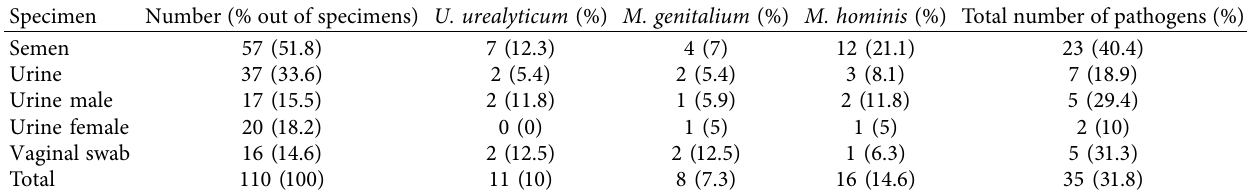
Table 2: Detection of U. urealyticum , M. genitalium, and M. hominis in different types of specimens. Specimen